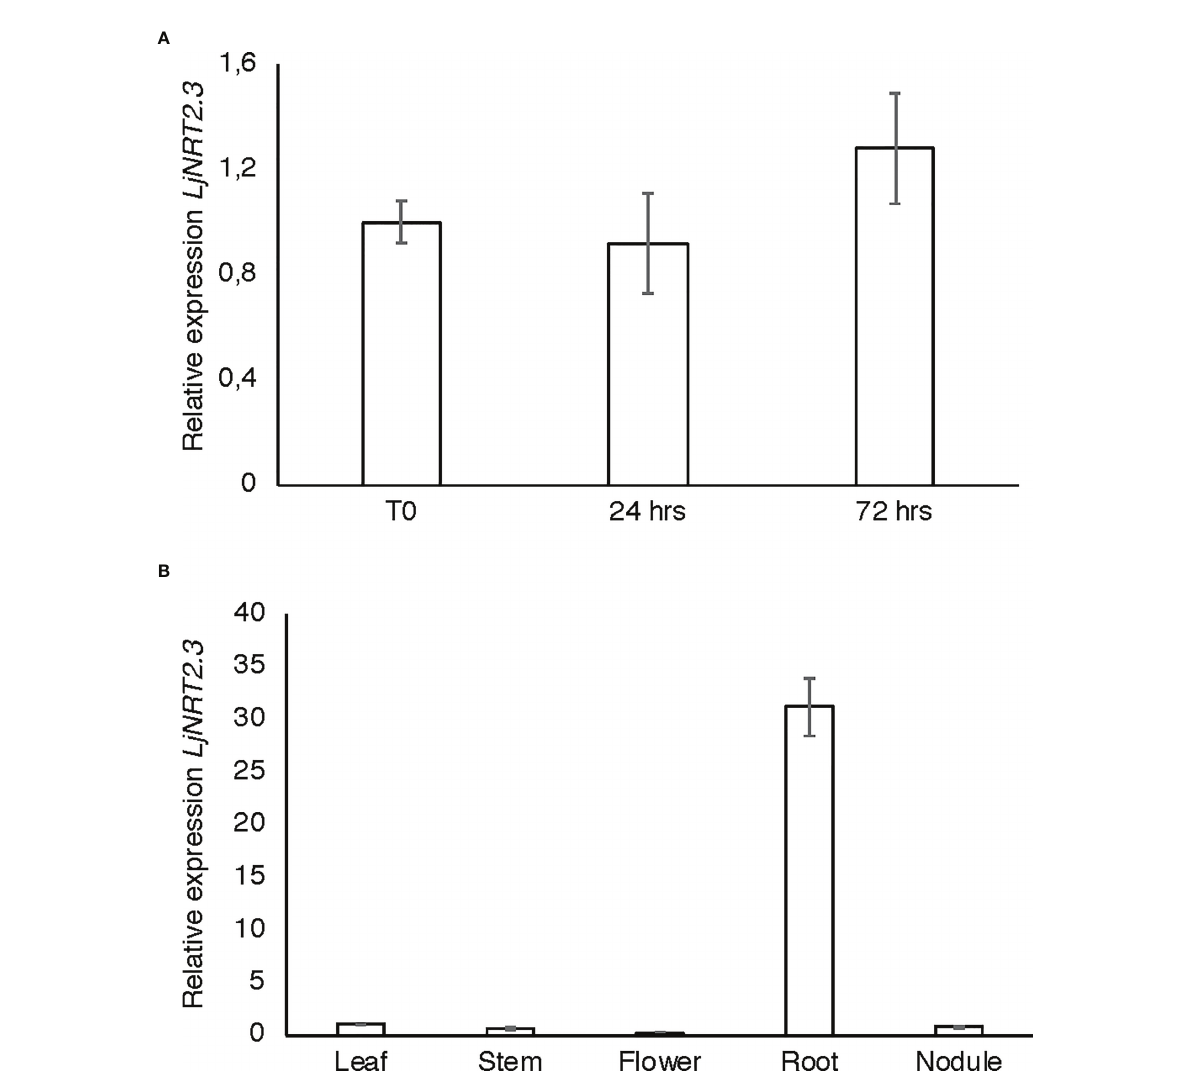
FIGURE 1 LjNRT2.3 transcriptional regulation. (A) Time course analysis in wild type L. japonicus root and nodule tissues after M. loti inoculation. RNAs were extracted from roots of seedlings grown in N starvation conditions at different times after inoculation (T0, 24 hrs, 72 hrs). (B) Expression in different organs. RNAs were extracted at four weeks after inoculation. Mature fl owers were obtained from Lotus plants propagated in the growth chamber. Expression levels obtained by qRT-PCR were normalized with respect to the internal control ubiquitin ( UBI ) gene and plotted as relative to the expression of T0 (A) and fl owers (B) . Data bars represent the mean and standard deviations of data obtained with RNA extracted from three different sets of plants and 3 real-time PCR